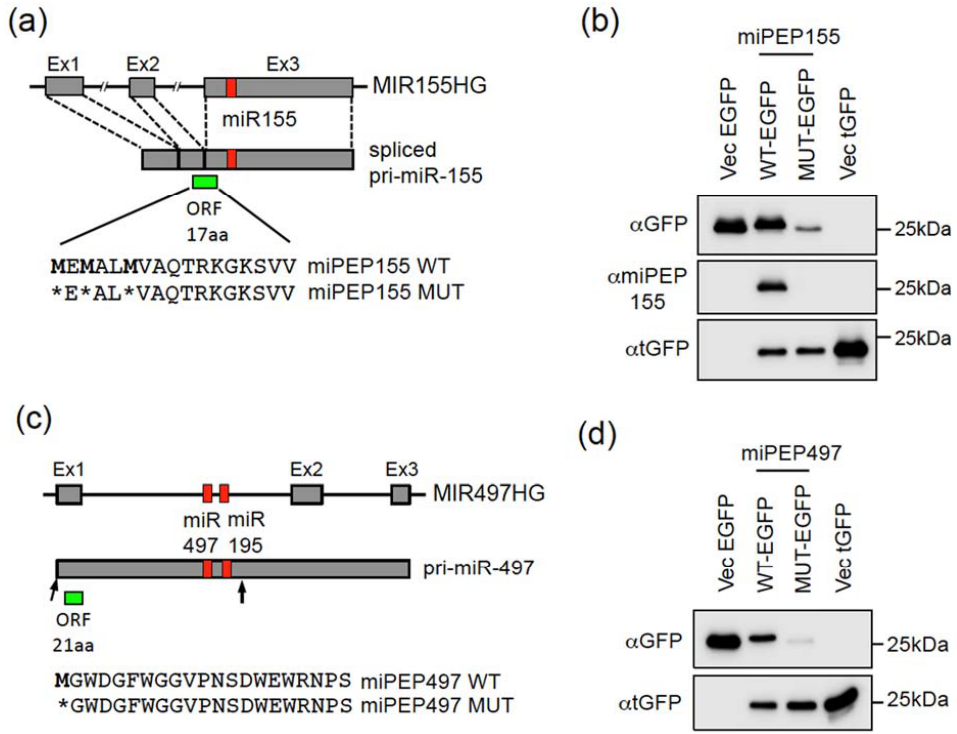
Figure 1. The pri-miR-155 and pri-miR-497 transcripts are translatable in Hela cells. ( a , c ) Schematic structures of human MIR155HG and pri-miR-155, ( a ) and MIR497HG and pri-miR497, ( c ) with the miRNAs (red boxes), sORFs (green boxes), and miPEP sequences indicated. *: mutation of ATG into stop codon. ( b , d ) Hela cells transfected with vectors expressing either the EGFP (Vec-EGFP) or turboGFP (Vec-tGFP) proteins or wild-type (WT) or mutated (MUT) miPEP155-EGFP ( b ) or miPEP497-EGFP ( d ) fusion proteins were analyzed by Western blot with the indicated antibodies. The vectors expressing miPEPs-EGFP proteins also express the turboGFP (tGFP) to monitor the transfection efficiency. According to Ensembl Genome Browser (http://www.ensembl.org, (accessed on 04